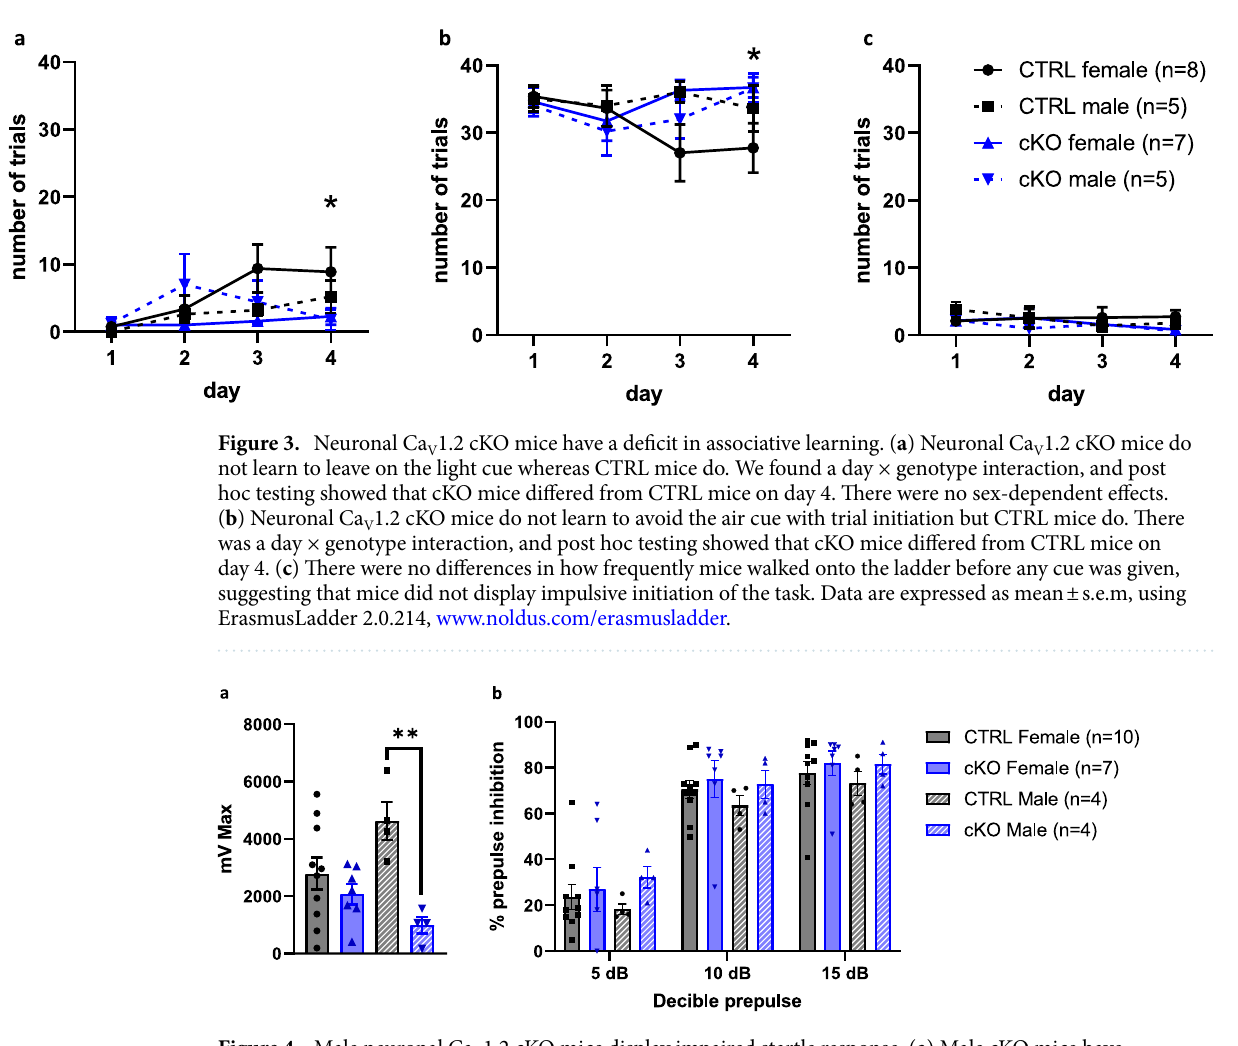
observed a genotype by sex interaction and a genotype by phase interaction effect in distance traveled (Linear mixed effect model, main effect genotype, F 1,21 = 2.20, p = 0.15, main effect sex, F 1,21 = 6.23, p < 0.03, main effect phase, F 1,21 = 1.68, p = 0.21, genotype × sex interaction effect, F 1,21 = 8.06, p < 0.01, genotype × phase interaction effect, F 1,21 = 9.12, p < 0.01) (Fig. 5a). Follow up testing showed that male cKO mice were more active during the habituation phase compared to male CTRL littermates (estimated marginal means, CTRL v cKO, habituation male, t 28 = − 3.80, p < 0.01) but there were no differences between female mice during the habituation phase (estimated marginal means, CTRL v cKO, habituation female, t 28 = 0.30, p = 0.77). Furthermore, there were no significant differences between genotypes during the preference phase (estimated marginal means, CTRL v cKO, preference female, t 28 = 1.51, p = 0.14, CTRL v cKO, preference male, t 28 = − 1.75, p = 0.09). Overall, our data show that CTRL males do not traverse this particular arena as much as cKO males either during habituation or social preference testing, but there are no differences in total exploration between CTRL females and cKO females. When testing for social preference, we observed a main effect of genotype, sex, and cylinder, a genotype by sex interaction, a genotype by cylinder interaction, and a sex by cylinder interaction (Linear mixed effect model, main effect genotype F 1,42 = 5.10, p < 0.03, main effect sex, F 1,42 = 4.33, p < 0.05, main effect cylinder, F 1,42 = 77.17, p < 0.01, genotype × sex interaction effect, F 1,42 = 6.55, p < 0.02, genotype × cylinder interaction effect, F 1,42 = 8.46, p < 0.01, genotype × sex interaction effect, F 1,42 = 6.55, p < 0.02). We found that cKO males do not show a sta- tistically significant preference for conspecific mice over an object (estimated marginal means, social v object, cKO male, t 21 = − 2.04, p = 0.05), which was not attributable to reduced total exploration time in male cKO mice (Fig. 5a). All other groups show a clear social preference (estimated marginal means, social v object, CTRL female, t 21 = − 7.90, p < 0.01, social v object, CTRL male, t 21 = − 4.17, p < 0.01, social v object, cKO female,